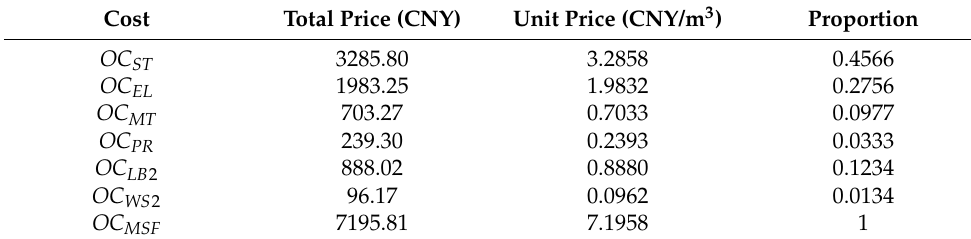
Table 15. BR-MSF system cost ratio table.